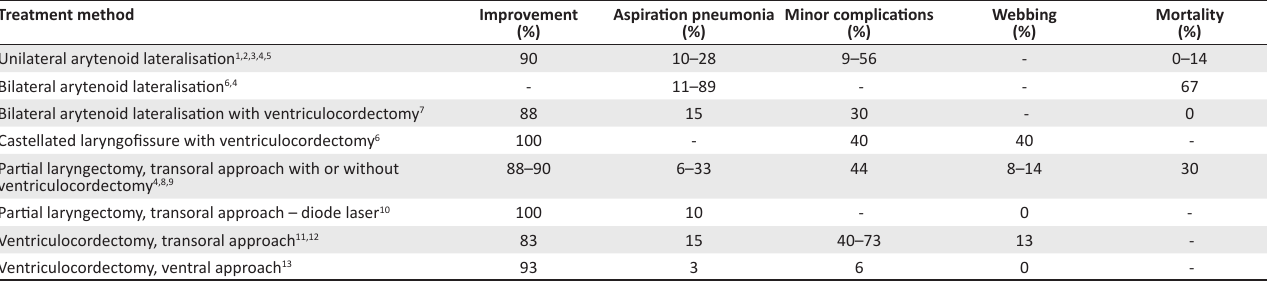
1 Source : Photograph by M. Doom FIGURE 5: Schematic presentation of unilateral partial laryngectomy on an embalmed cadaver specimen of the canine larynx, indicating the area of the arytenoid cartilage to be removed in blue (1) and the location of the vocal fold in red (2).